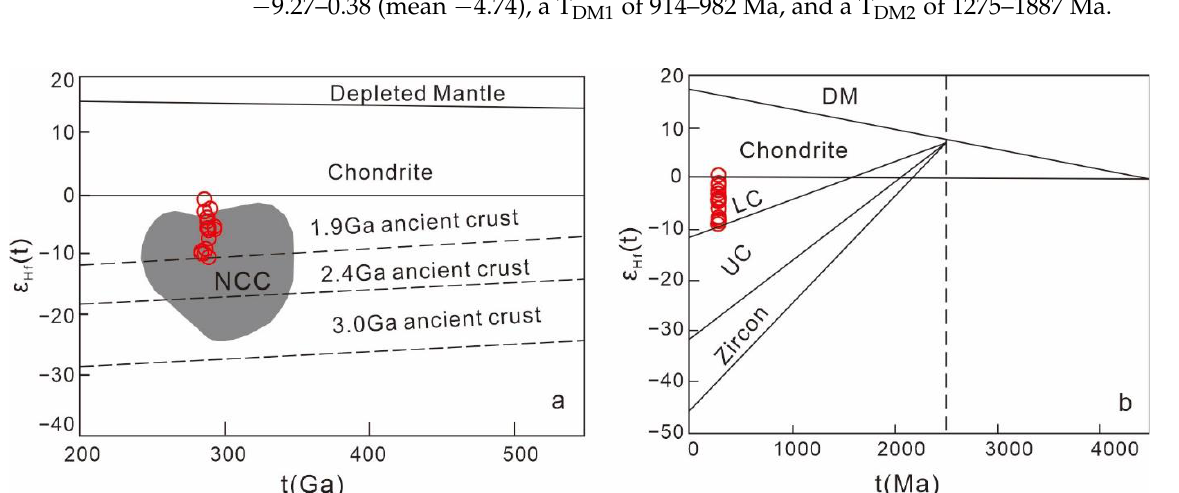
Figure 6. ε Nd (t)-t diagrams of the Zhaojinggou monzogranite. The initial Sr-Nd isotopic compositions of granites were rectified by the correspond- ing zircon U-Pb age of 286.7 Ma. The 87 Sr/ 86 Sr values of granites ranged from 0.715233 to 0.716612, and the average value was 0.7160, which was obviously higher than the original mantle value ( 87 Sr/ 86 Sr = 0.7045, [23]). The 143 Nd/ 144 Nd values of granites ranged from 0.511989 to 0.512021, and the average value was 0.512000, which was slightly lower than